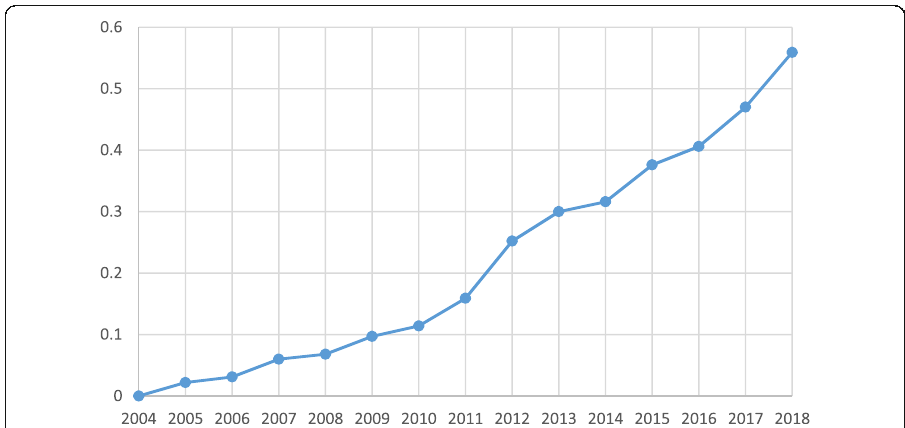
Fig. 4 Citation links between IMISCOE-member-authored articles, controlled for by numbers of